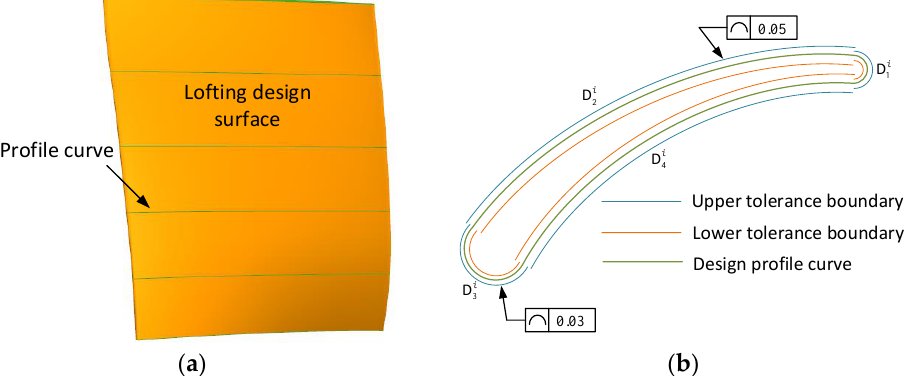
Figure 1. ( a ) The design surface is constructed based on profile curves by the lofting method; ( b ) different tolerance bands on different segments of the profile curve.